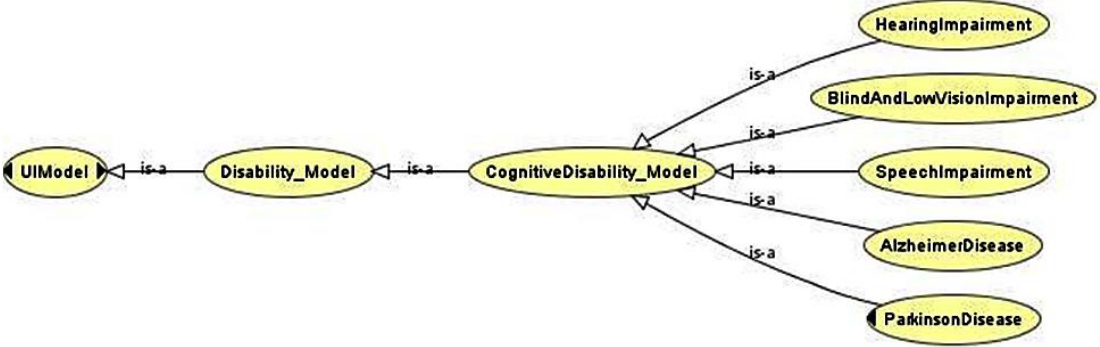
Figure 8. Ontology representation of the modeled cognitive disabilities.